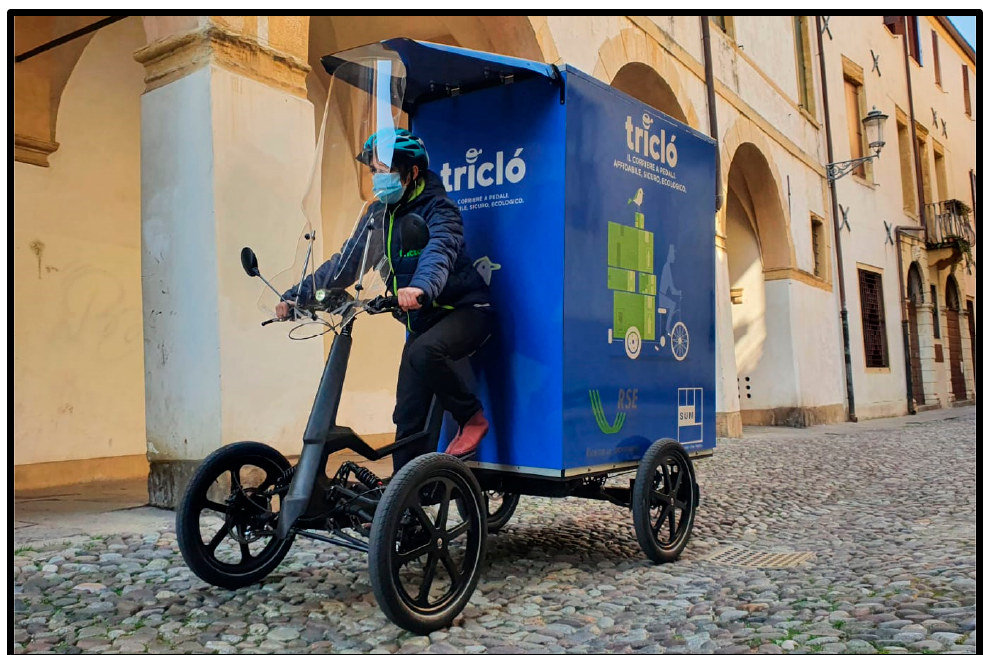
Figure 2. SUM-X, the e-cargo bike assessed and monitored in the study.